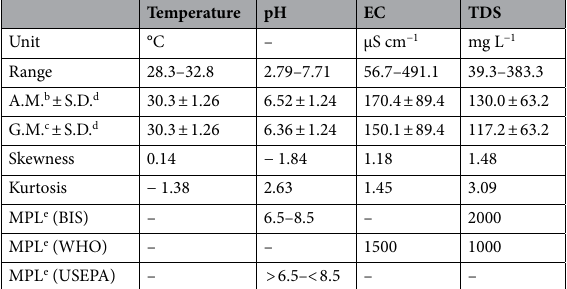
Table 5. Statistical values of observed physico-chemical characteristics in water samples of Mandakini valley, Uttarakhand, India (N a = 72). a Number of samples, b Arithmetic mean, c Geometric mean, d Standard deviation, e Maximum permissible limit.